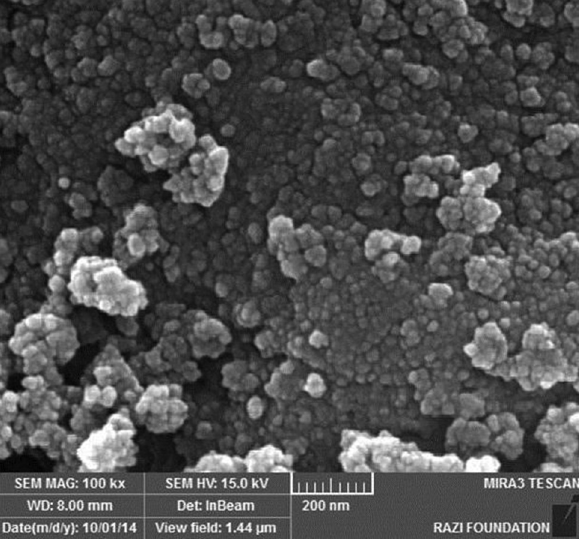
O (b) Fe O @SiO 3 4 3 4